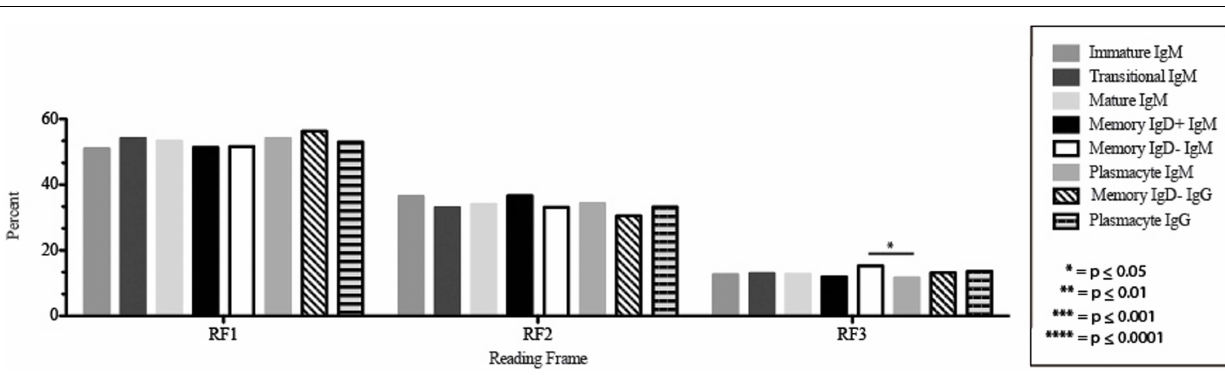
FIGURE 10 | D H reading frame usage in Ig µ and Ig γ transcripts from selected B cell populations in the blood of a normal, healthy human. The percent of sequences using members of the specified D H family members in reading frames 1, 2, or 3 among in-frame sequences cloned from the